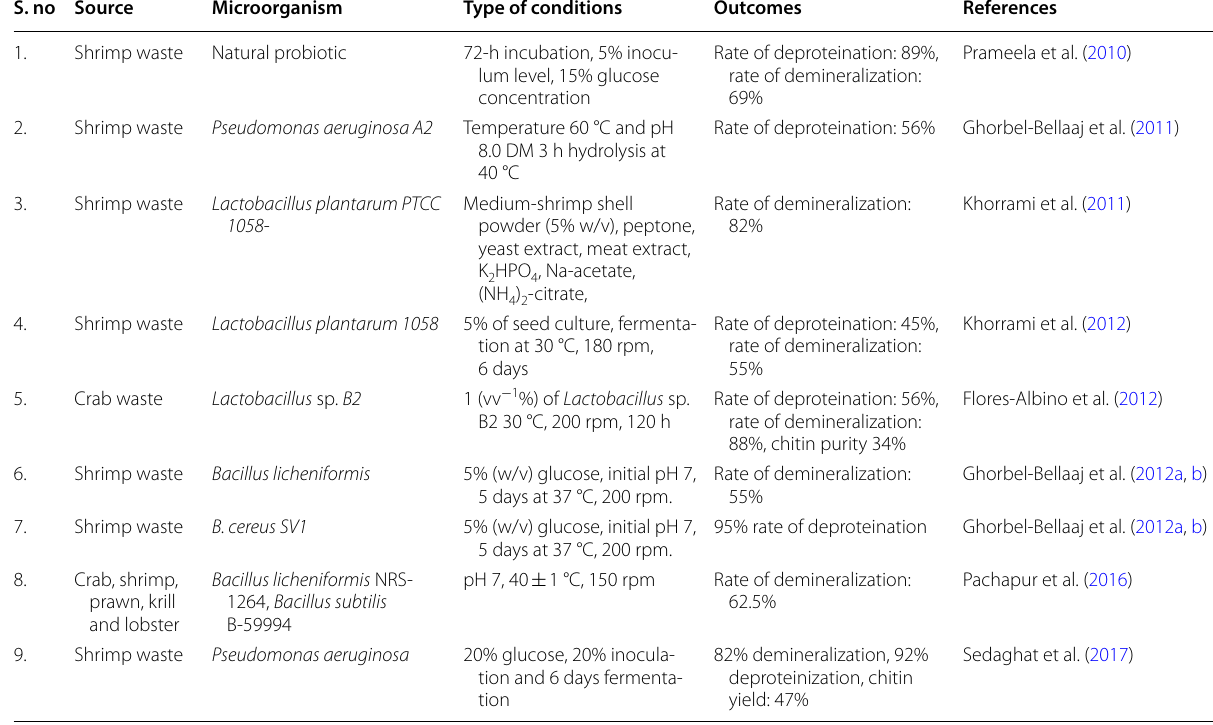
Table 2 Biological extraction methods for recovery of